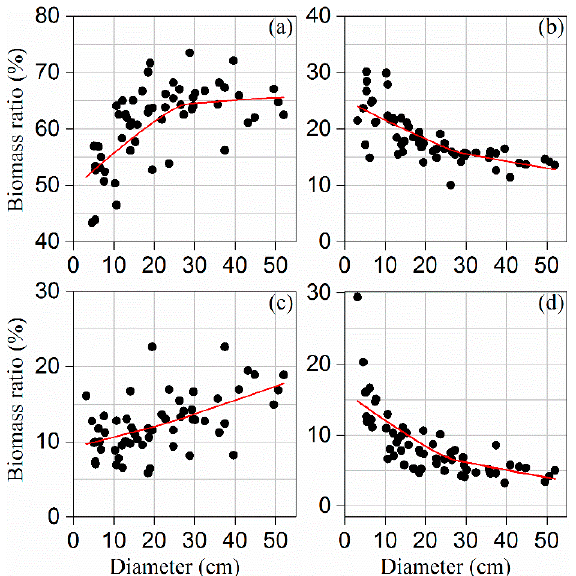
Figure 3. The fraction of aboveground biomass allocated in wood ( a ), bark ( b ), branch ( c ), and leaf ( d ) varied with dbh . Red solid lines are lowess smoothers.